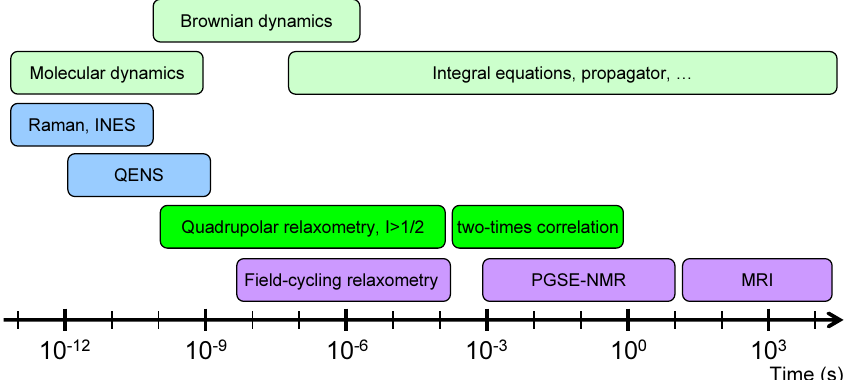
Figure 1. Schematic view of the different time-scales explored by various experimental and numerical dynamical